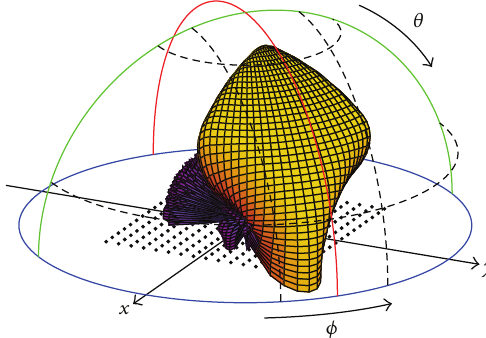
Figure 5: Steering 𝑆 𝑓 off the principal axes (50 ∘ , 35 ∘ ) results in an even more severe warping of the shaped region. The boundaries of the shaped region are also wrongly oriented, leading to a different angular coverage.